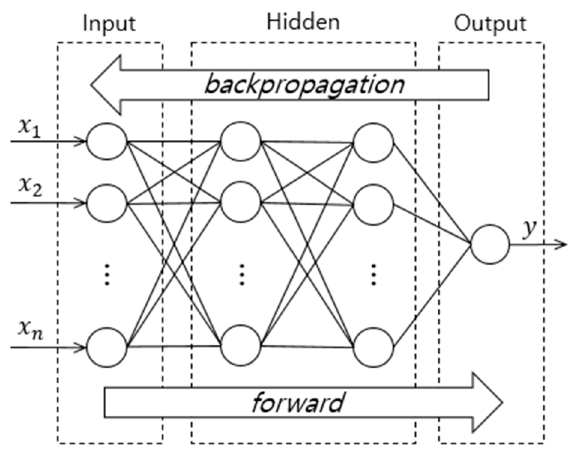
Figure 2. BPNN Structure.